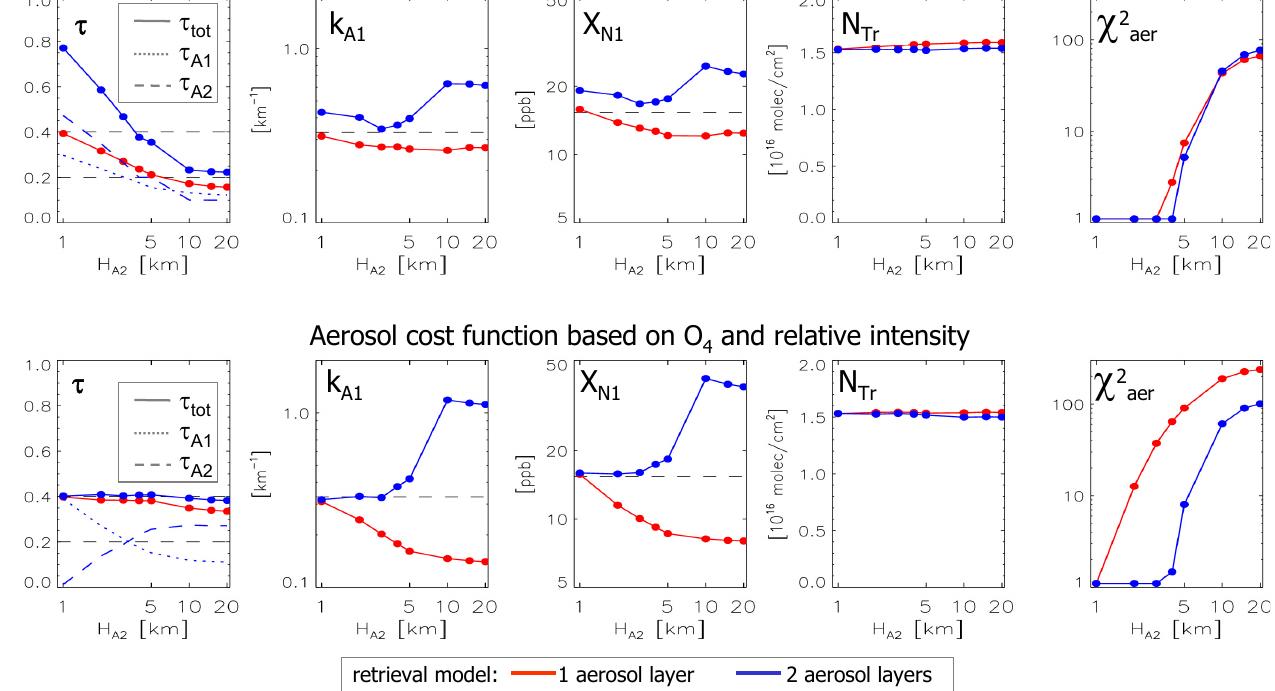
Fig. 9. Sensitivity study E (elevated aerosol layers). The top row shows aerosol retrievals based solely on differential slant column measurements of O 4 . The retrievals shown in the bottom row are done with a cost function where not only O 4 but also relative intensity measurements were used. The black dashed lines indicate prescribed values in the sensitivity study, i.e. the truth in the simulation. In the first column not only the total AOT is shown (0.4), but also the AOT of the boundary layer (0.2). Only the 1 NO 2 layer retrieval model was used for the NO 2 retrieval. Note that the 2nd, 3rd and 5th column have a logarithmic scale on the y-axis.